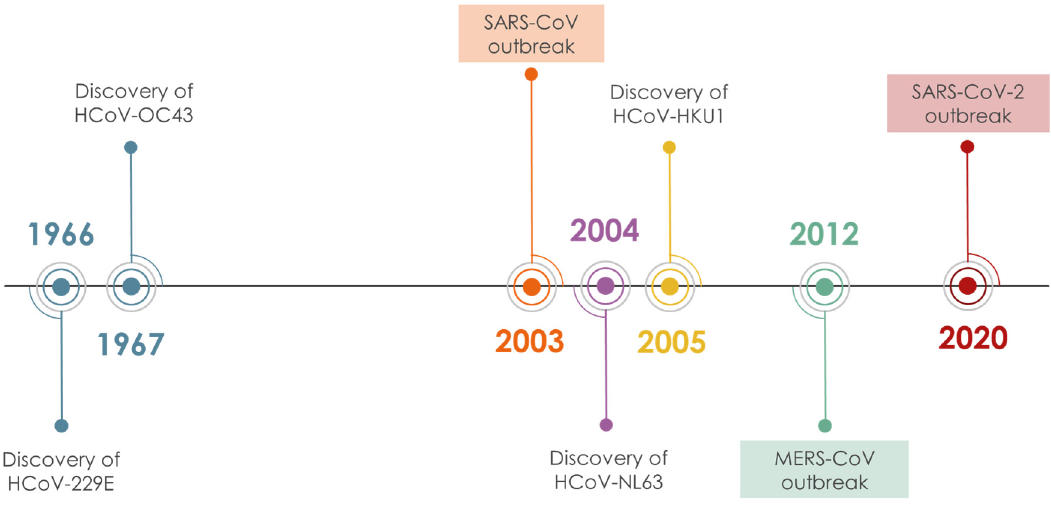
Figure 1. Timeline of HCoV discovery.